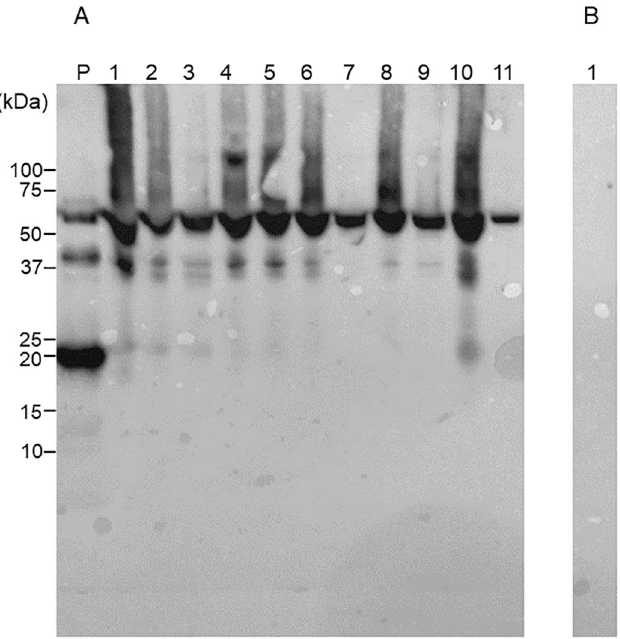
Fig 4. Cytokeratin (CK) 13 in the saliva of patients with rheumatoid arthritis (RA) and healthy participants. Twelve microliters of saliva per lane were subjected to sodium dodecyl sulfate-polyacrylamide gel electrophoresis. A: Immunostaining was performed using an anti-CK13 antibody as the primary antibody and horseradish peroxidase- conjugated goat anti-rabbit IgG antibody as the secondary antibody. Lane P: positive control (recombinant CK13), Lanes 1–5: saliva from patients with RA; Lanes 6–11: saliva from healthy participants. B: Immunostaining was performed using only HRPO-conjugated goat anti-rabbit IgG antibody without primary antibody. Lane 1: Saliva from a healthy